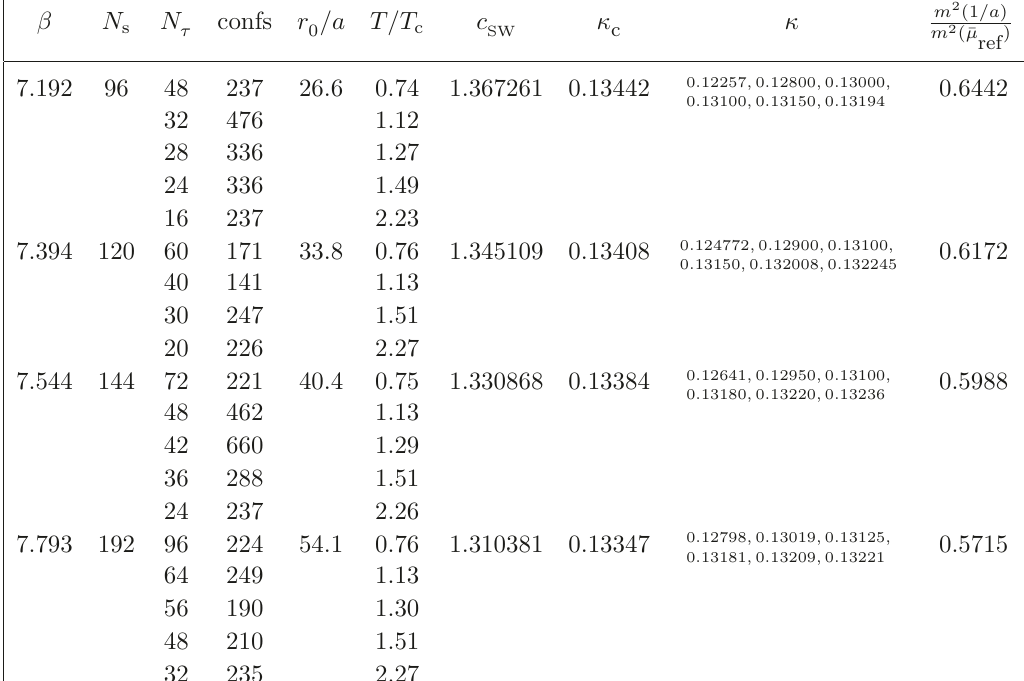
Table 2 . The lattices (of geometry N 3 N ) included in the current analysis. The measurements s × τ of r /a at low temperatures are based on our own measurements of large Wilson loop expectation 0 values, and correspond to a sector of fixed trivial topology, due to the freezing of topological degrees of freedom [56]; we refrain from estimating systematic uncertainties. When citing physical units, we make use of r = 0 . 47(1) fm from ref. [50]. Conversions to units of T c are based on r T c = 0 . 7457(45) 0 0 /a , together with the older one summarized in table 2 of ref. [57], from ref. [57]. Our new data for r 0 which include classic results from refs. [58, 59], can be well represented ( χ 2 /d.o.f. = 1 . 43) by eq. (4) = 8 . 9664, c = 19 . 21, c = 5 . 25217, c = 0 . 606828. of ref. [57], with the modified couplings c 1 2 3 4 − − The Sheikholeslami-Wohlert coefficient c [60] and the critical Wilson hopping parameter κ c are SW 1 = 1 . The evolution of in accordance with ref. [61]; the bare lattice mass is am L 2 κ − 2 κ c